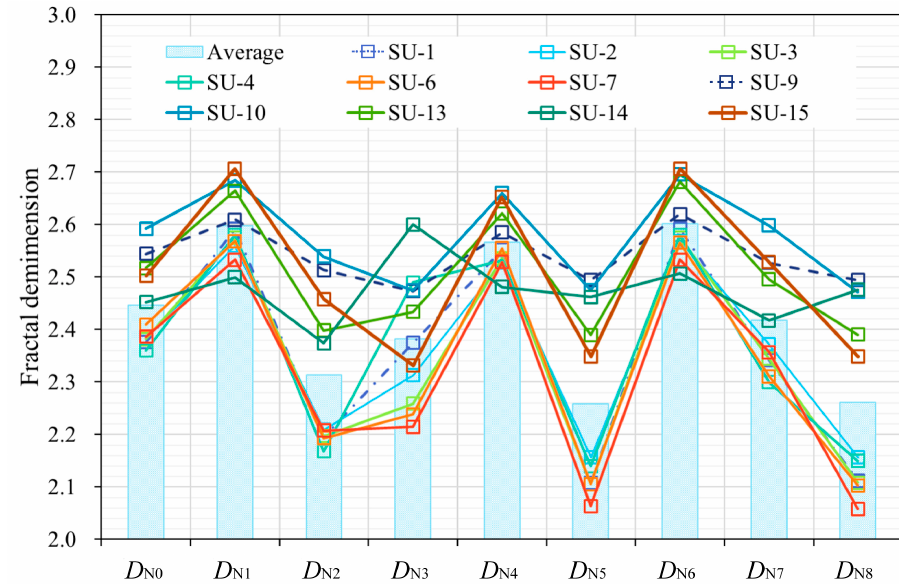
Figure 15. Di ff erent types of fractal dimension numerical distribution range in di ff erent tight Figure 15. Different types of fractal dimension numerical distribution range in different tight sandstone.